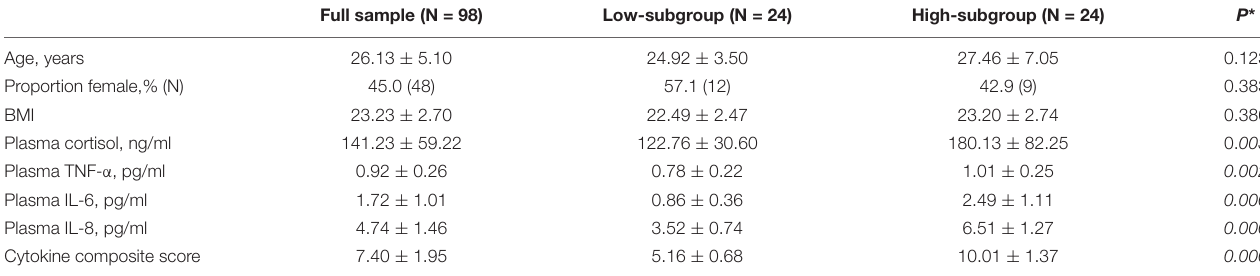
TABLE 1 | Full sample and subgroup characteristics.